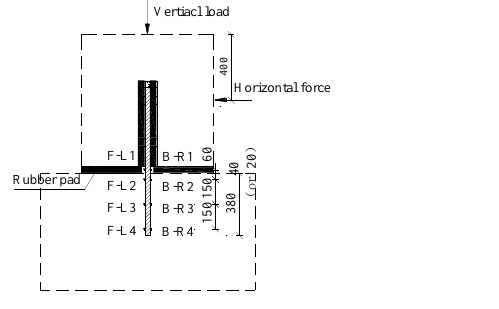
Figure 5. Strain gauge arrangement on the steel dowel (unit: mm).